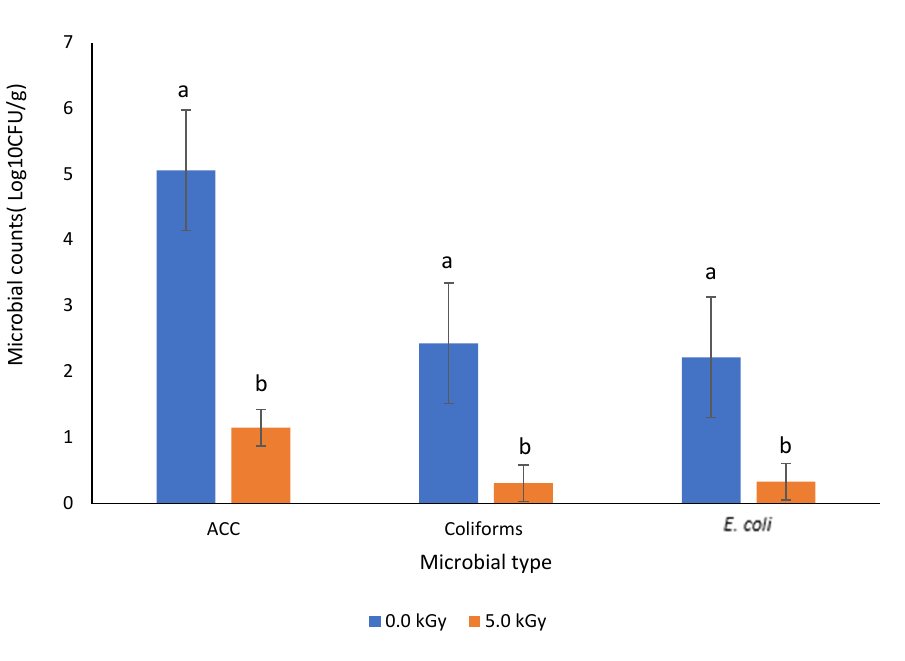
Figure 2. Microbial counts at the 0.0-kGy and 5.0-kGy irradiation treatments of artisanal pecorino- style hard cheese ( n = 24). Different superscripts indicate a difference ( p < 0.05). ACC: Aerobic colony counts; E. coli : Escherichia coli .